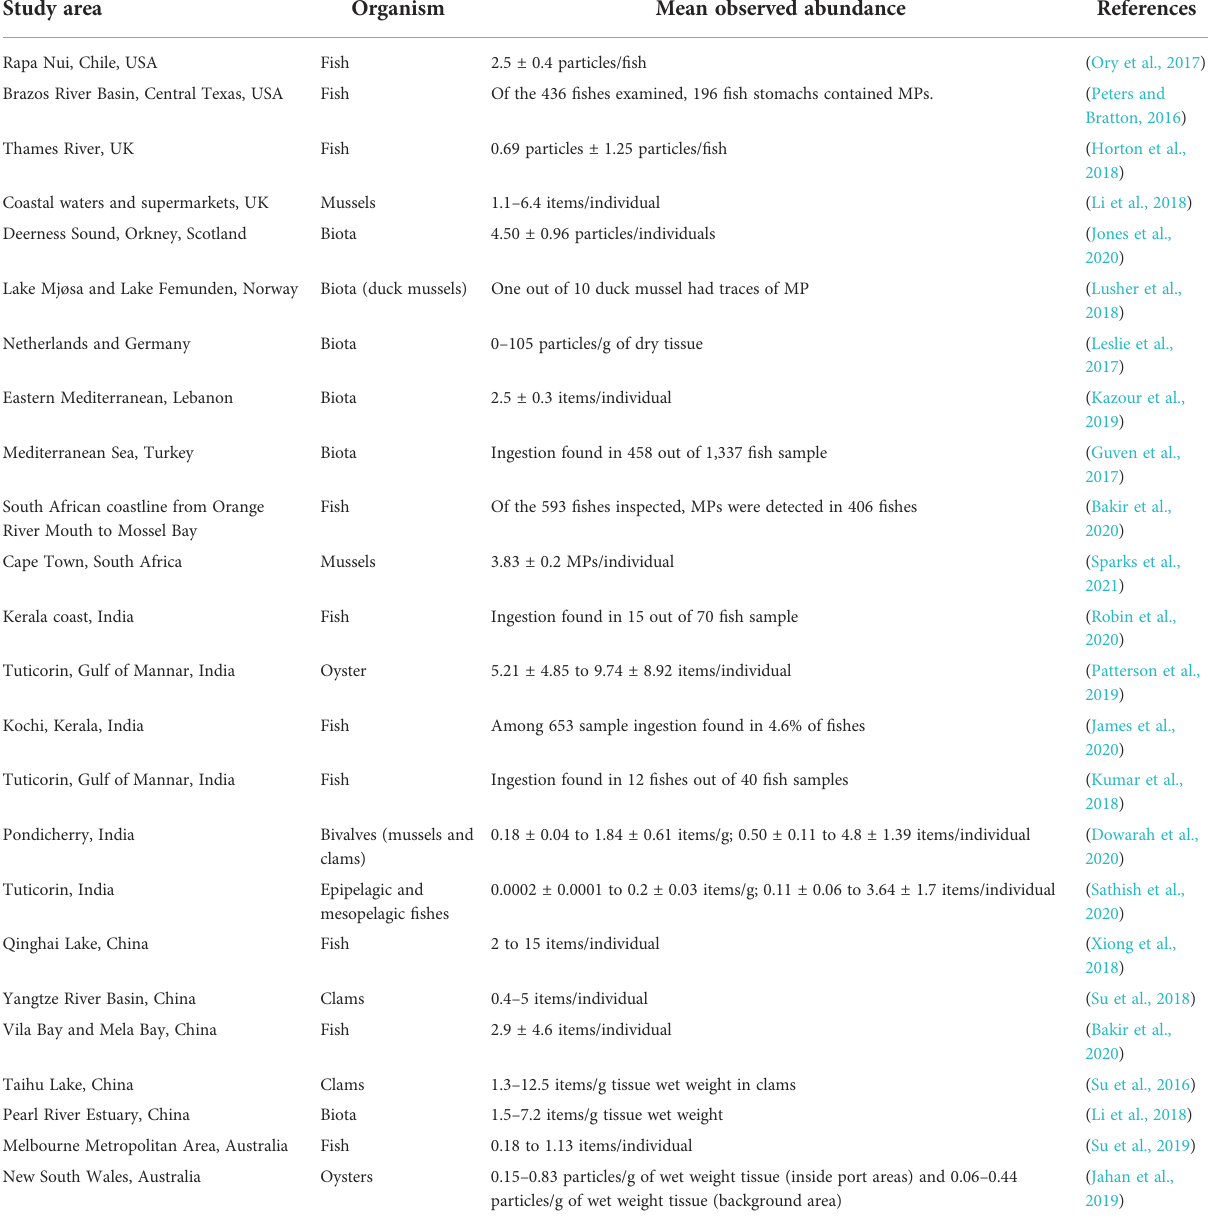
TABLE 3 Studies on MP abundance in biota summarized from selection of reports across the globe.